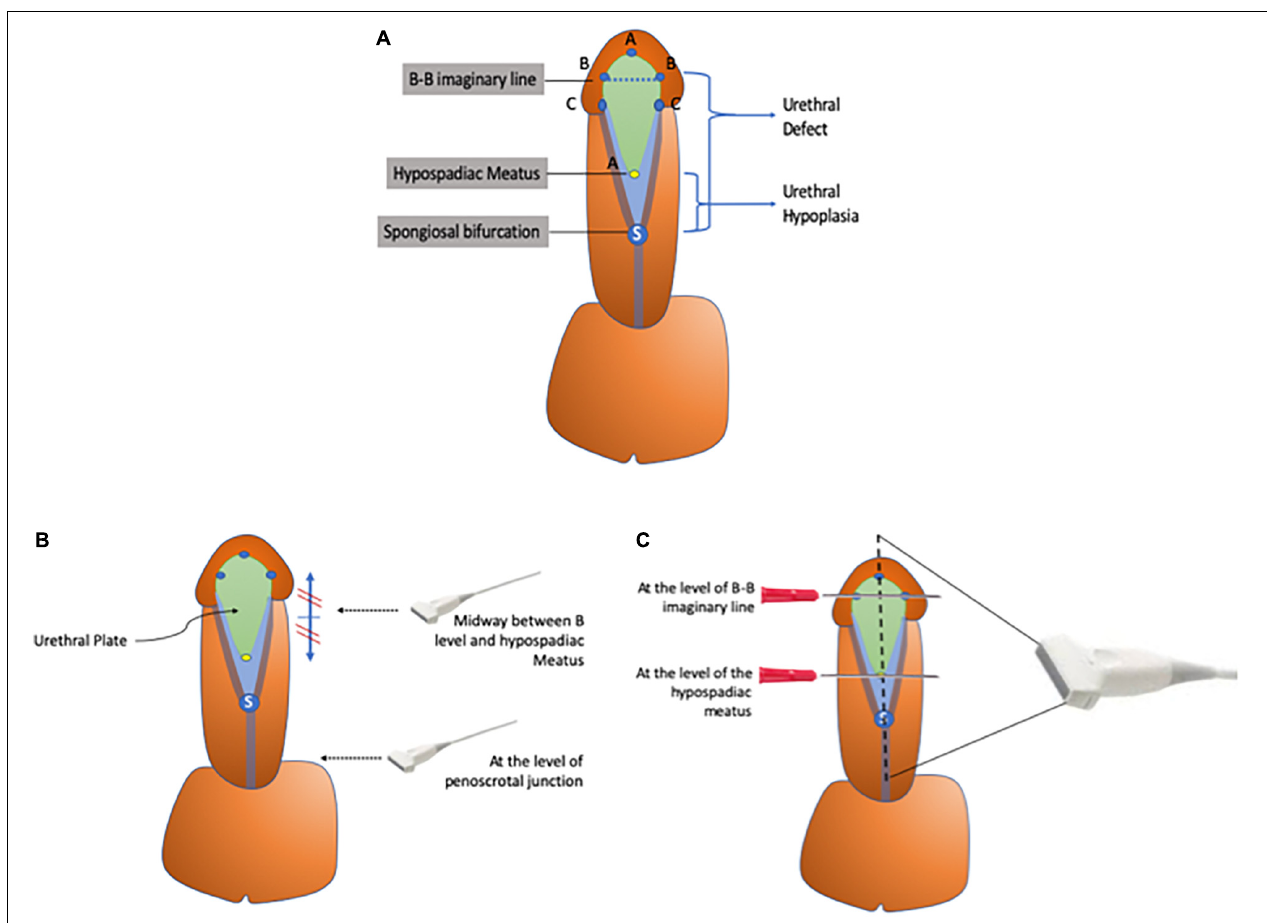
FIGURE 1 | (A–C) Diagram representing key anatomical landmarks. (A) Illustration showing the different anatomical landmarks used to define urethral hypoplasia. (B) Two transverse images are captured: one at the peno-scrotal junction and the other midway between the hypospadias meatus and B-B line. (C) Longitudinal sagittal imaging over the midline of the penile shaft with two metal landmarks at the B-B line and hypospadiac meatus.